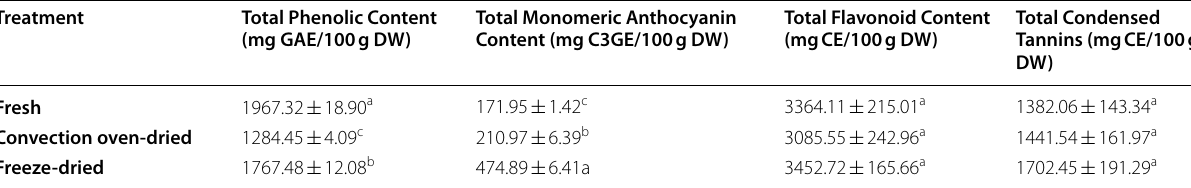
Values are expressed as mean ANOVA and Tukey’s HSD test